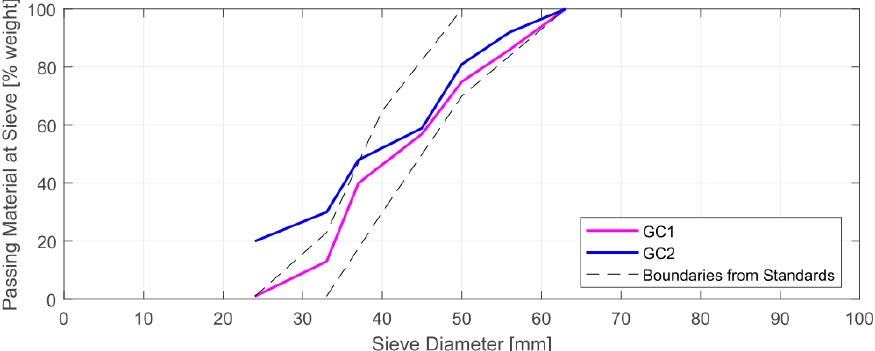
Figure 1. Outcomes of the sieving test on the ballast samples used for the tests.